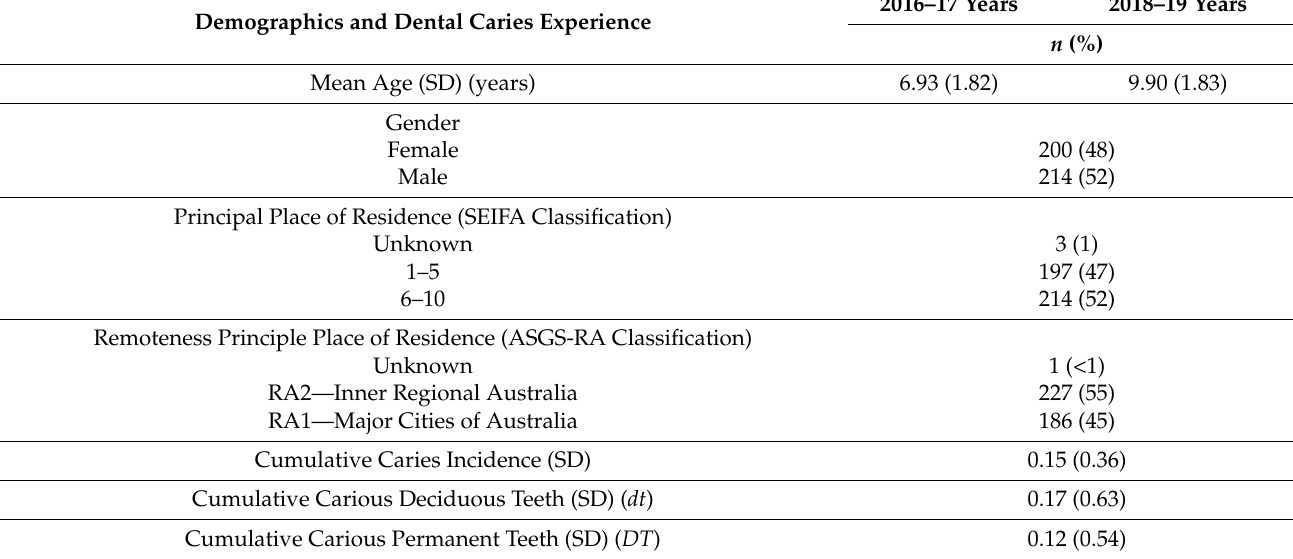
Table 1. Summary of the descriptive statistics of children receiving dental care from the Teeth on Wheels dental program